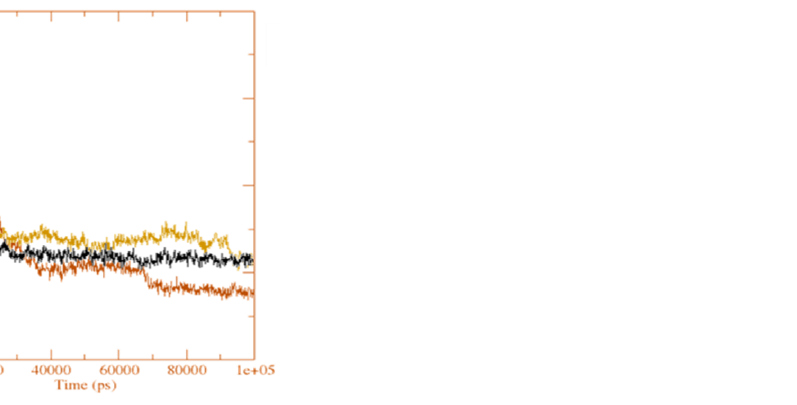
Figure 14. The number of average hydrogen bonding interactions between ( a ) the CuGS complex and ( b ) GpnS complex during the 100 ns simulation time.